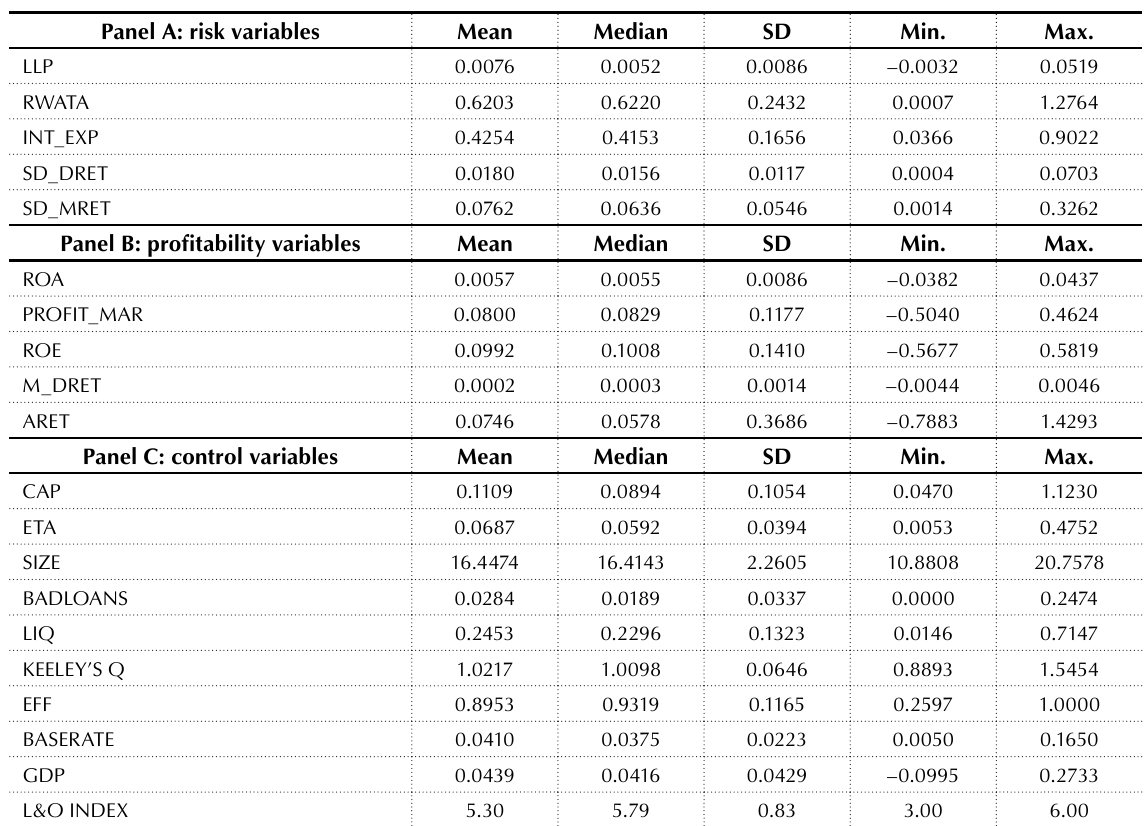
Table 4. Descriptive